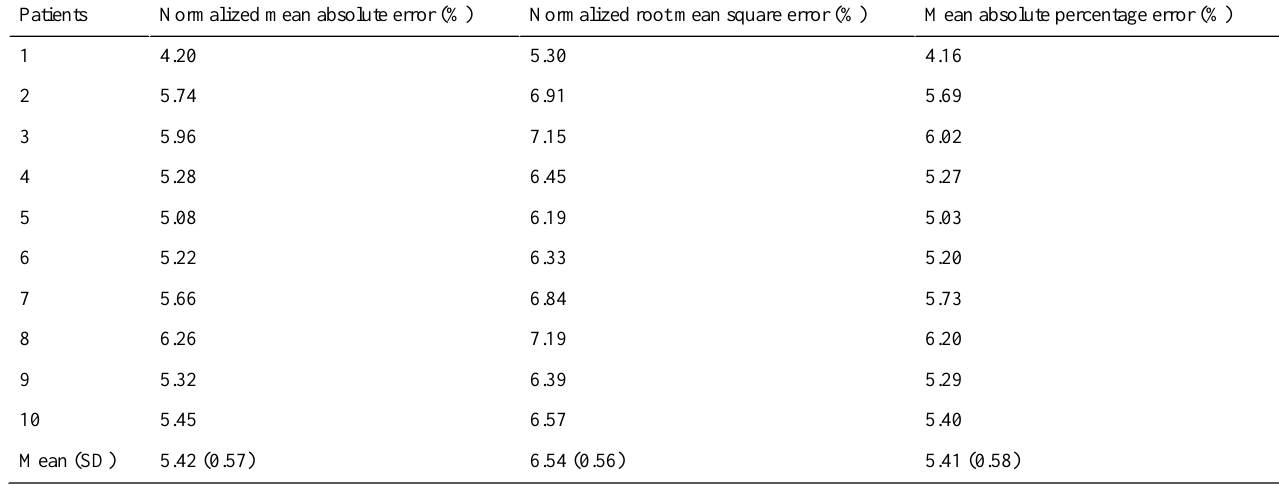
Table 2. Normalized mean absolute error, normalized root mean square error, and mean absolute percentage error for heart rate estimation.